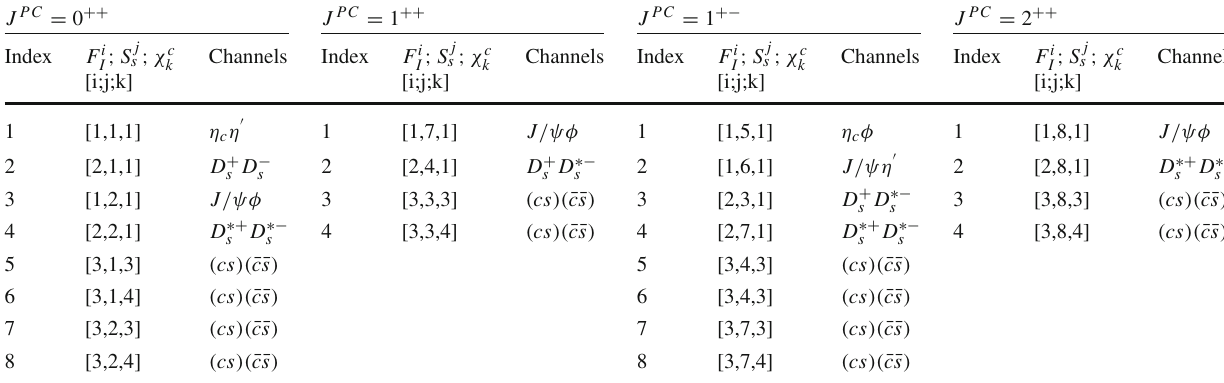
Table 3 All possible channels for all quantum numbers